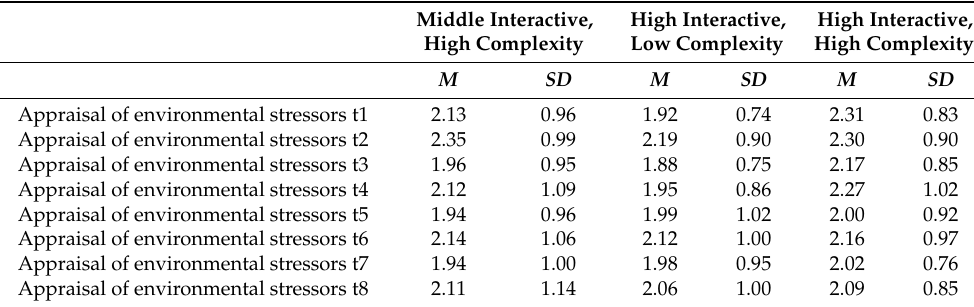
Table 2. Descriptive statistics for the levels of the variables of interest in the current study.